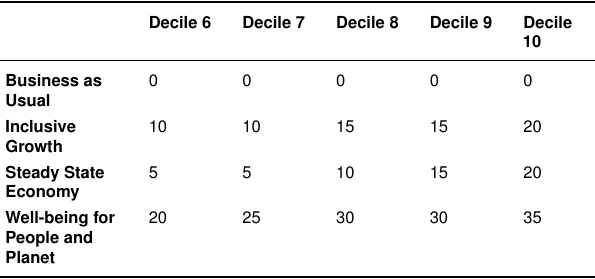
Table 3. Income tax rates (%) in different